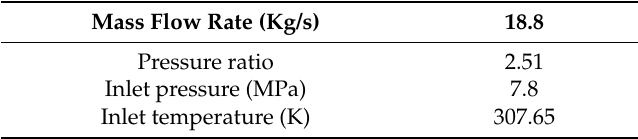
Table 5. Design parameters for a 1 MWe centrifugal